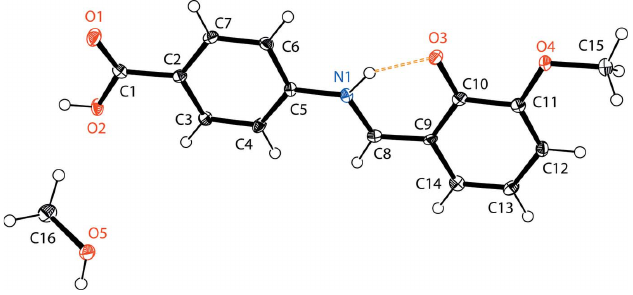
Figure 1 The molecular structure of the title compound, showing the atom labelling and the intramolecular N—H (cid:2)(cid:2)(cid:2) O hydrogen bond as a dashed line. Displacement ellipsoids are drawn at the 40% probability